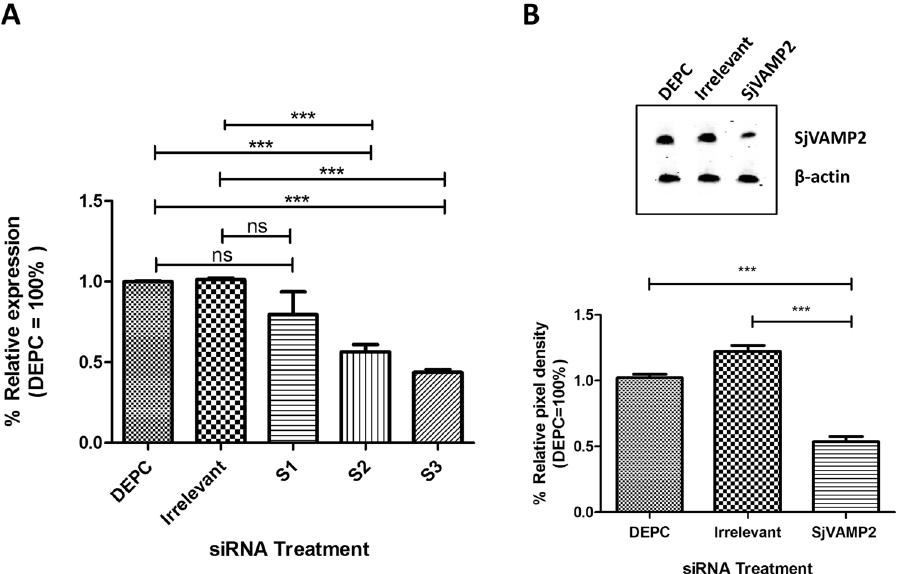
Figure 1. SjVAMP2 gene expression analysis. ( A ) Relative gene expression of SjVAMP2 in parasites 6 days after treatment with DEPC ultra pure water, irrelevant siRNA or three SjVAMP2 specific siRNAs (S1, S2, and S3). ( B ) Protein levels in worm extracts obtained 6 days following treatment with the indicated S3 siRNA. Western blotting results of Sj VAMP2 protein were shown in the top panel with β -actin protein as loading control. Ratio of the optical density of Sj VAMP2 to β -actin was analyzed by imageJ 89 . Data show the mean and standard errors derived from three independent experiments ( *** P < 0.001).